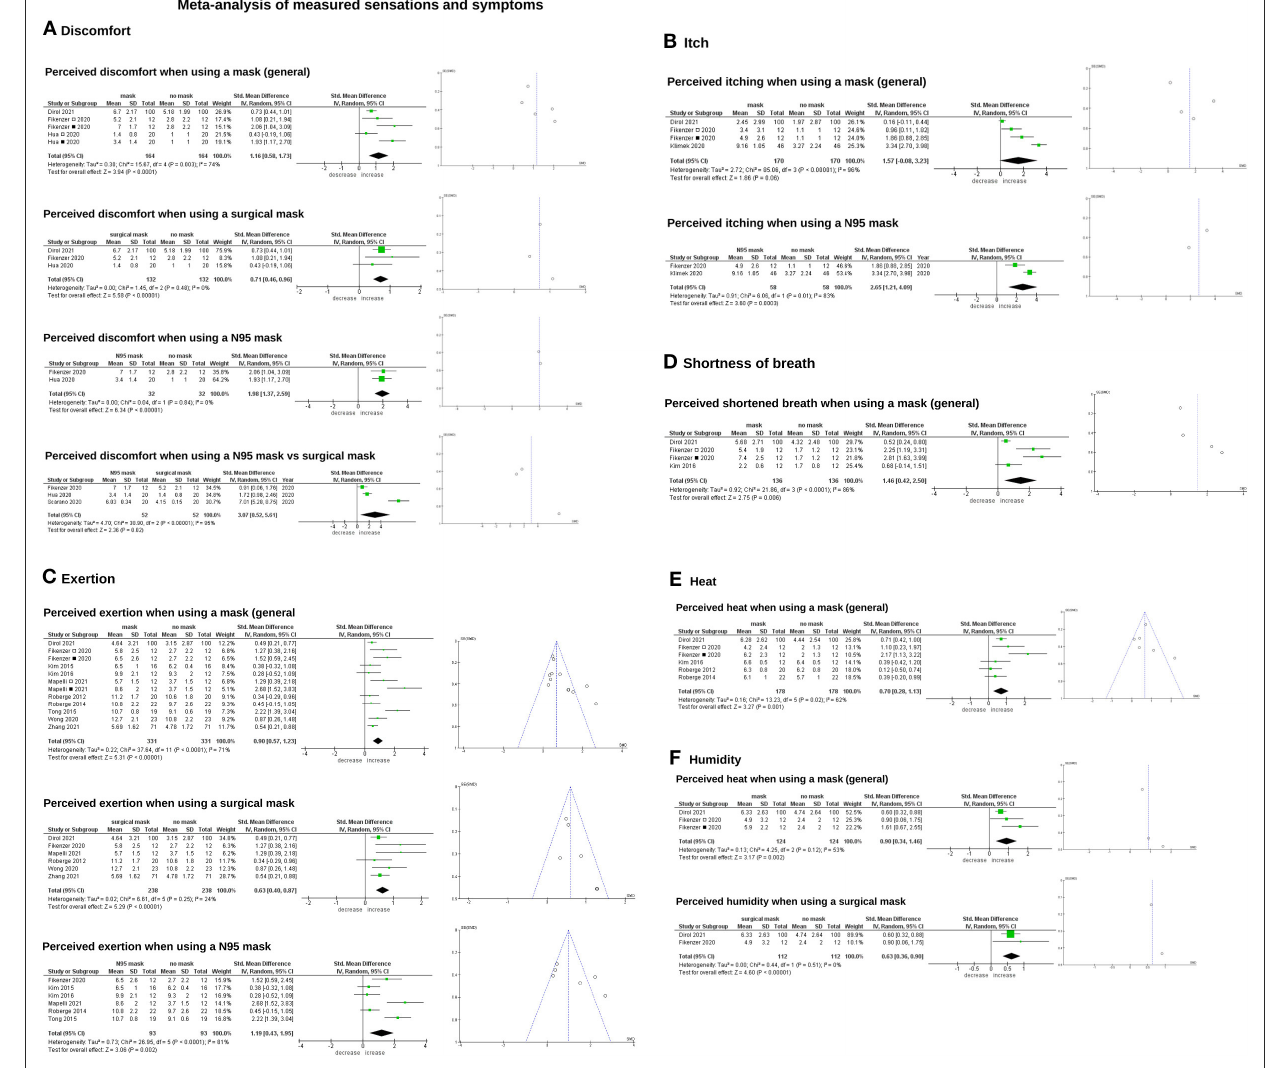
FIGURE6 Forest and funnel plots of meta-analysis of measured discomfort (A) , itch (B) , exertion (C) , shortness of breath (D) , perceived heat (E) , and humidity (F) during face mask use (VAS, Likert-scales or similar) in an evaluated population of n 373. All face mask types are initially considered together, = later subgroups (surgical and N95) are evaluated. If studies examine two different mask types in parallel, the corresponding studies are marked: (cid:3) = surgical mask (cid:4) N95 mask. (A) Perceived discomfort is significantly higher in face mask use in the pooled analysis. This could be found for general = mask use, in the subgroup analysis for surgical-, and for N95 mask use. A pooled analysis comparing both conditions (surgical mask and N95 mask) resulted in statistically significant higher discomfort rates for the N95 mask than the surgical mask. (B) An overall significance for itching could be found for mask use. Also in N95 mask use the perceived itching was statistically significantly elevated according to the pooled subgroup analysis.